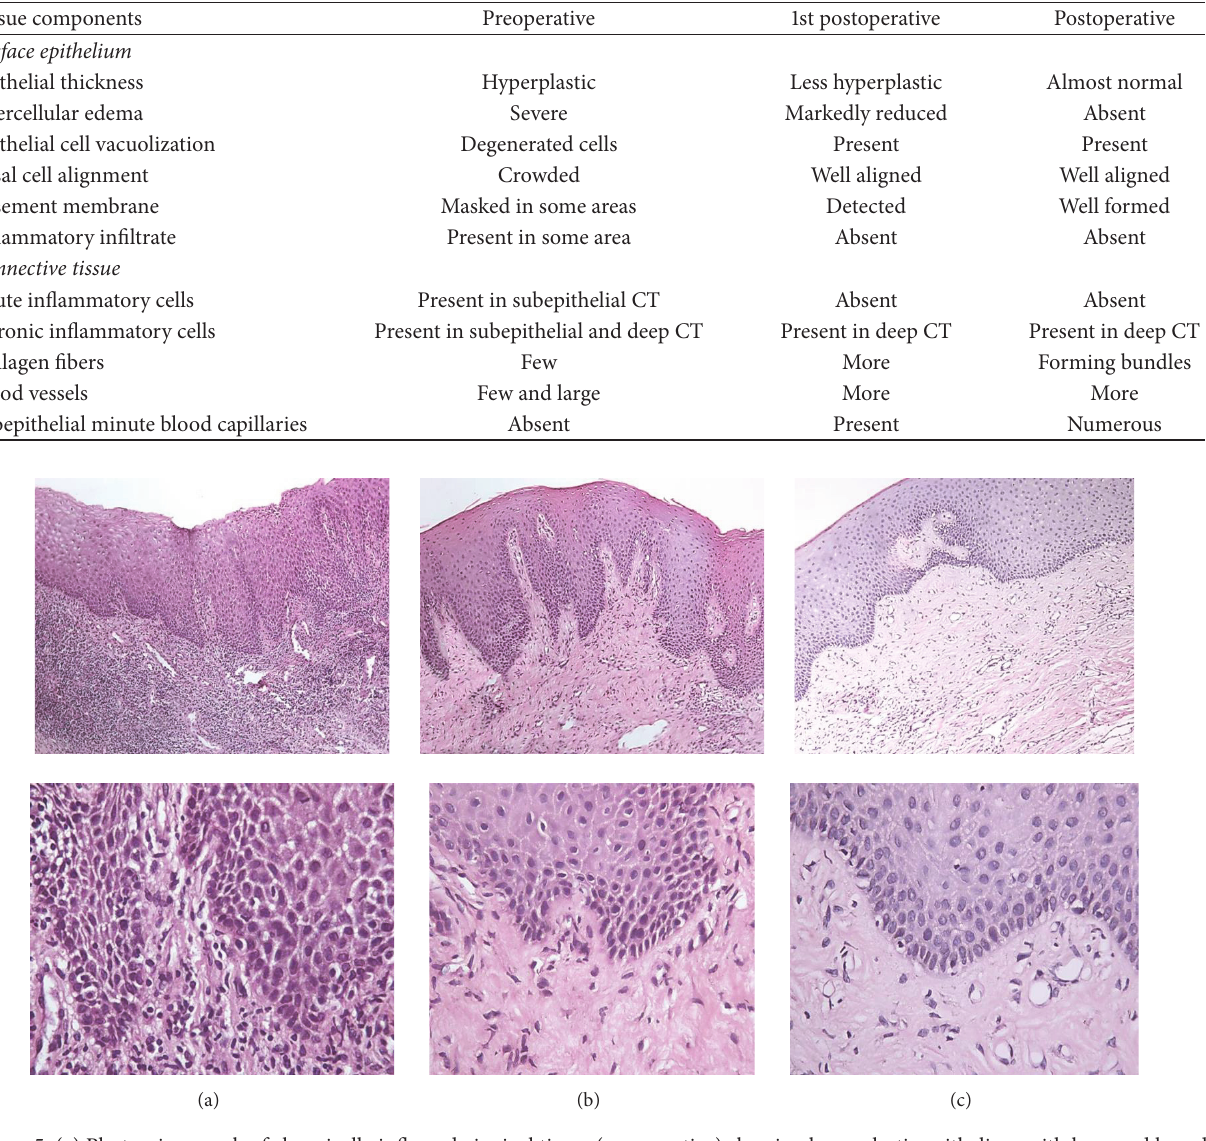
Figure 5: (a) Photomicrograph of chronically inflamed gingival tissue (preoperative) showing hyperplastic epithelium with long and broad rete ridges and intense inflammatory cell infiltrate in superficial and deep CT ( × 100). Intraepithelial edema and intense inflammatory cell infiltrate formed of acute and chronic inflammatory cells ( × 400). (b) Photomicrograph of the same case after single injection of vit-C showing hyperplastic epithelium with slightly narrower rete ridges, numerous minute blood capillaries, collagen fibers formation, and mild inflammatory cell infiltrate ( × 100). Reduced intercellular edema with fewer chronic inflammatory cells and collagen fibers formation were detected ( × 400). (c) Photomicrograph of the same case after two injections (in two sessions) of vit-C showing marked reduction in epithelial thickness, superficial minute, and deep larger blood capillaries, collagen fiber bundles formation, and mild inflammatory cell infiltrate ( × 100). Marked reduction of vacuolized epithelial cells, reduced intercellular edema, well-demarcated basement membrane, increased number of blood capillaries, and almost absence of inflammatory cells ( ×